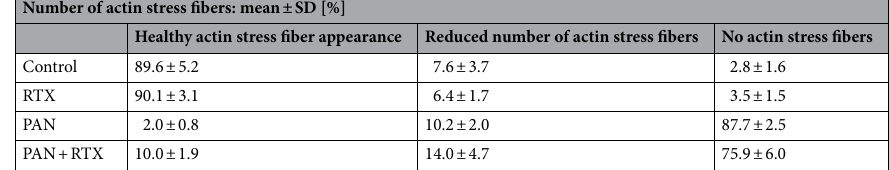
Table 1. Rituximab prevents destruction of actin stress fibers in human podocytes. To evaluate the integrity of the actin cytoskeleton podocytes were divided into three groups: "healthy actin stress fiber appearance", "reduced number of actin stress fibers" and "no actin stress fibers". RTX = rituximab (100 µg/ ml); PAN = puromycin aminonucleoside (30 µg/ml). Treatment time: 48 h; n = 4 experiments; ≥ 25 images per condition. Data are means (%) ±